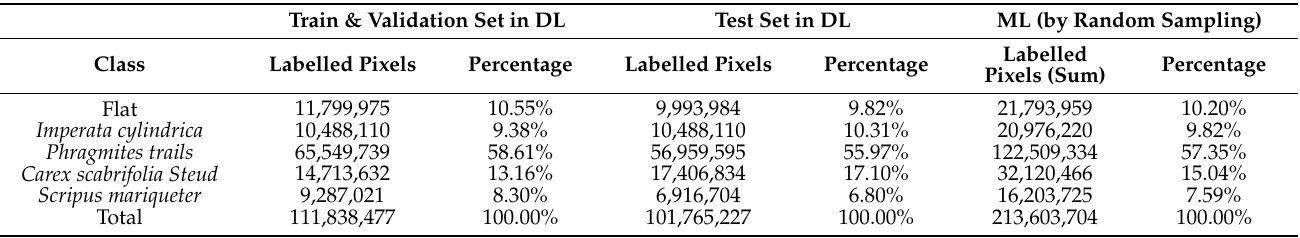
Table 1. Number and percentage of manually labeled pixels of each class in different training sets for ML and DL. Train & Validation Set in DL Test Set in DL ML (by Random